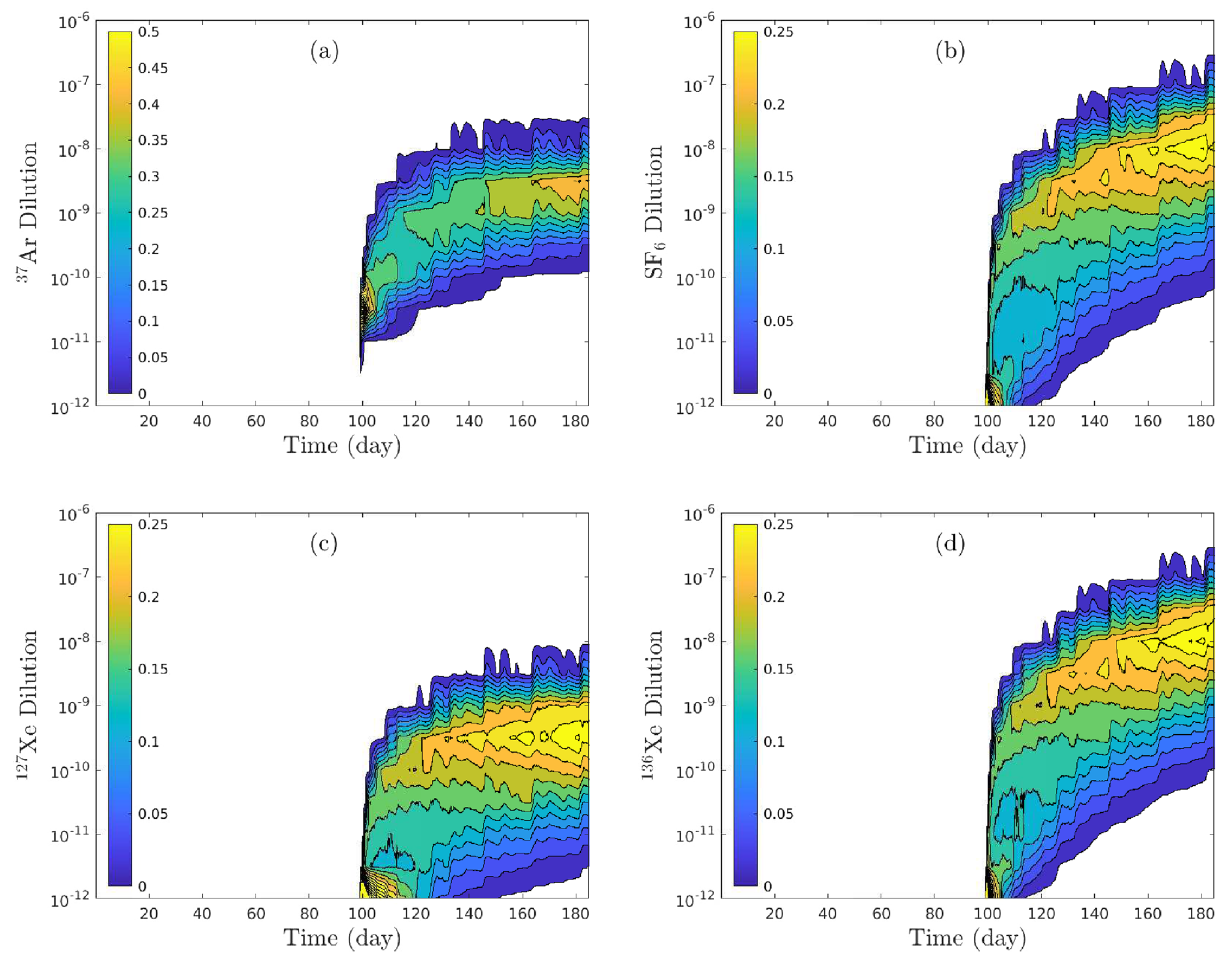
37 127 136 Ar, ( b ) SF 6 , ( c ) Xe, and ( d ) Xe relative concentrations at ground